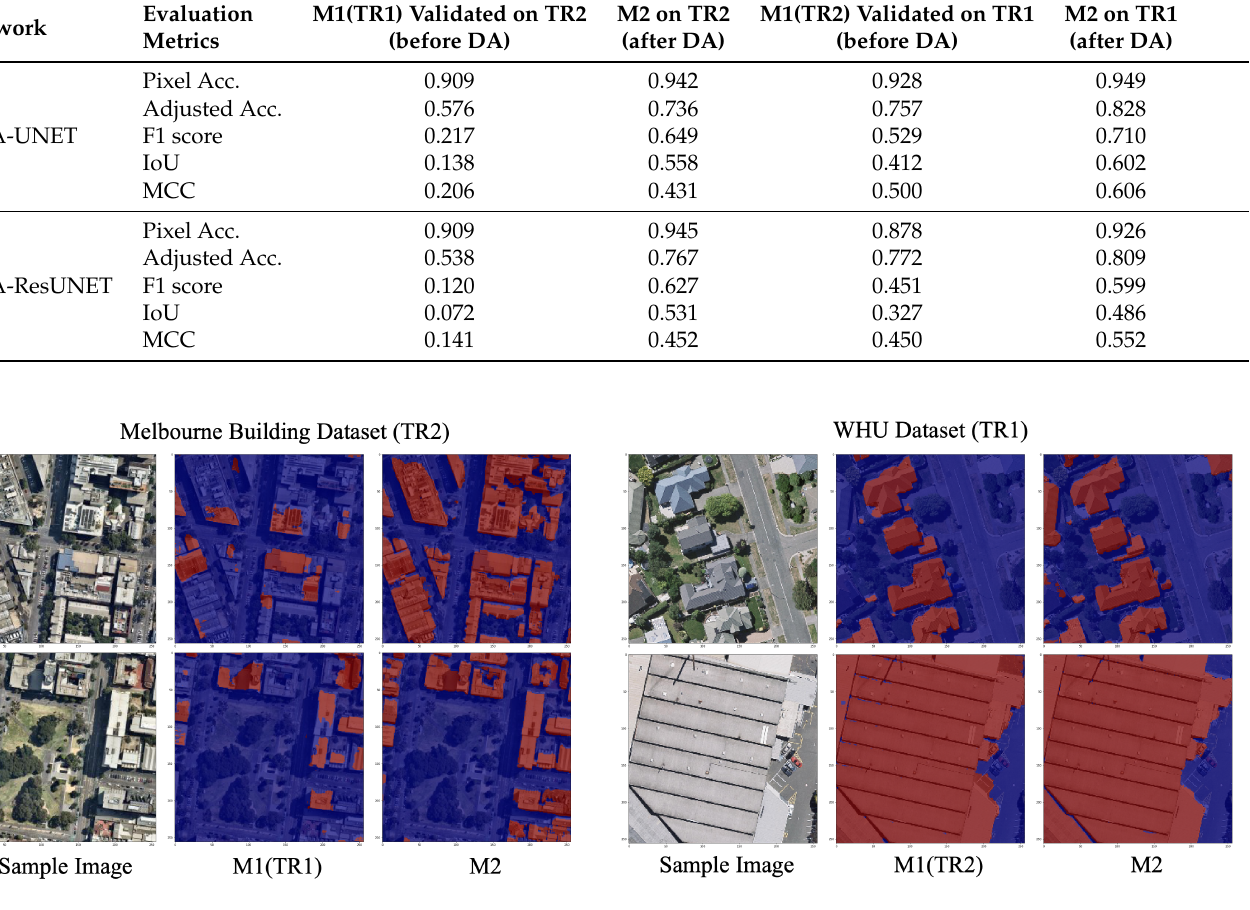
Figure 9. Sample results from cross-domain validation of the base model (M1) and domain-adapted model (M2) experimented with MSA-UNET. The two samples on the left compare M1(TR1) to M2 to show before and after supervised DA on the TR2 dataset. Similarly, the two samples on the right compare M1(TR2) to M2 to show before and after supervised DA on the TR1